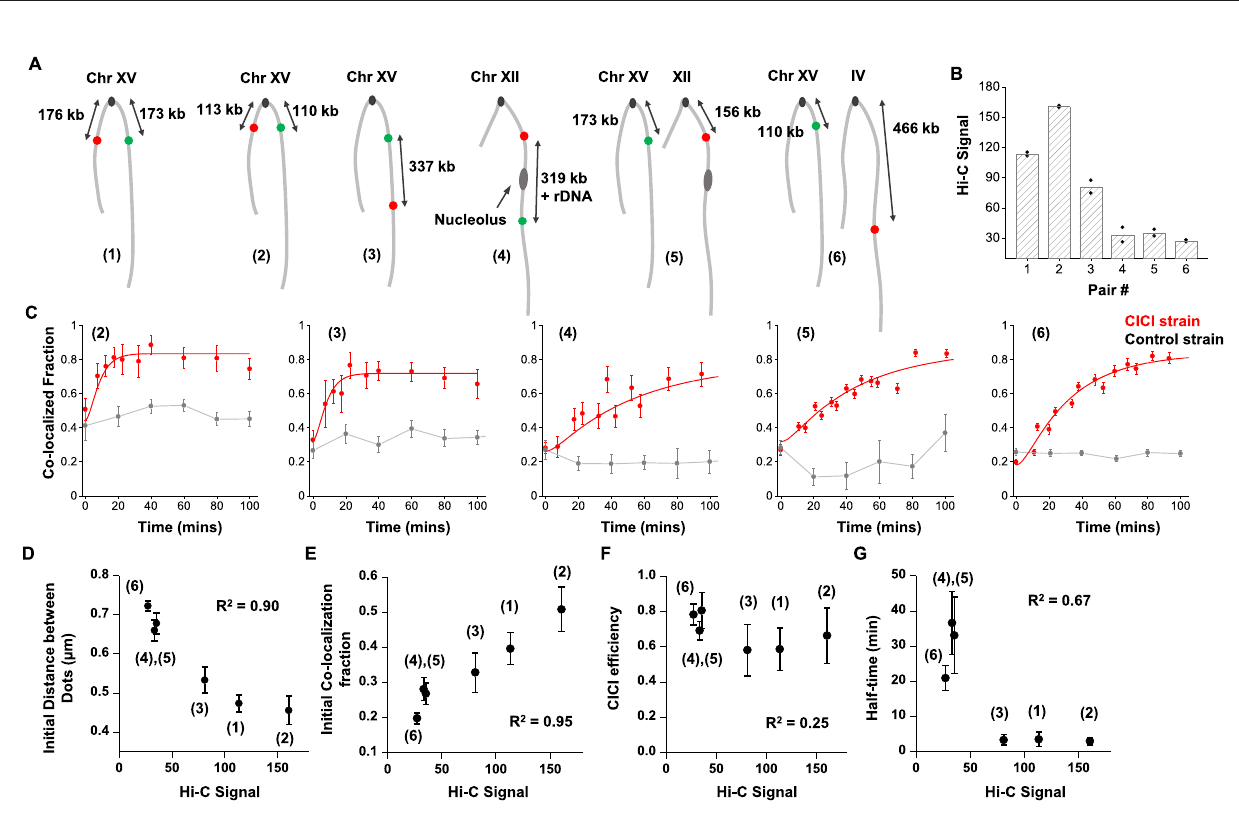
Fig. 1 Implementation of CICI. A The scheme of CICI. LacO and TetO arrays were inserted into two genomic loci. Fusion proteins LacI-FKBP12 and TetR- FRB associated with these arrays dimerize in the presence of rapamycin. LacI-GFP and TetR-mCherry were also included for visualization. B LacO (green dot) and TetO (red dot) arrays are integrated 150 kb from the centromere on the left and right arms of Chr XV. C Visualization of the CICI strain (containing the complete CICI system in ( A )) and the control strain (containing LacI and TetR instead of LacI-FKBP12 and TetR-FRB) ± rapamycin. D Histograms of distances between the two dots in the CICI strain (upper panel) and in the control strain (lower panel) ± rapamycin. The + rapamycin histogram includes measurements where the CICI or control strains were incubated with rapamycin for 1 – 2 h. In total, 116, 102, 407, and 308 cells were measured, respectively. The co-localization fraction in each condition is shown in the plots. E Fraction of co-localization as a function of rapamycin incubation time in the CICI (red) or the control strain (black). The total numbers of data points were 436 for CICI and 912 for control. Data are presented as mean values ± SEM. Source data for D and E are provided as a Source Data fi le.